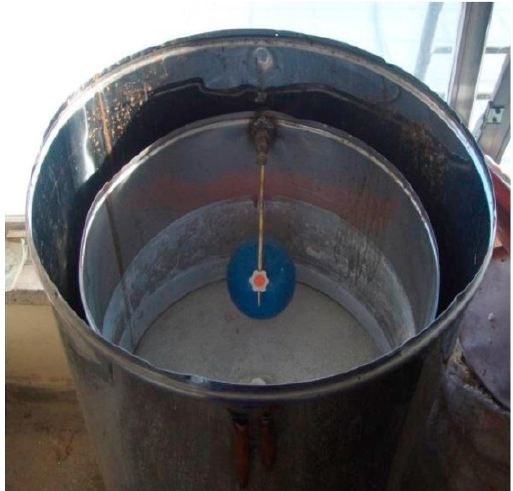
Figure 12. Schematic diagram of ( a ) direct heat exchange mode and ( b ) indirect heat exchange mode [38].